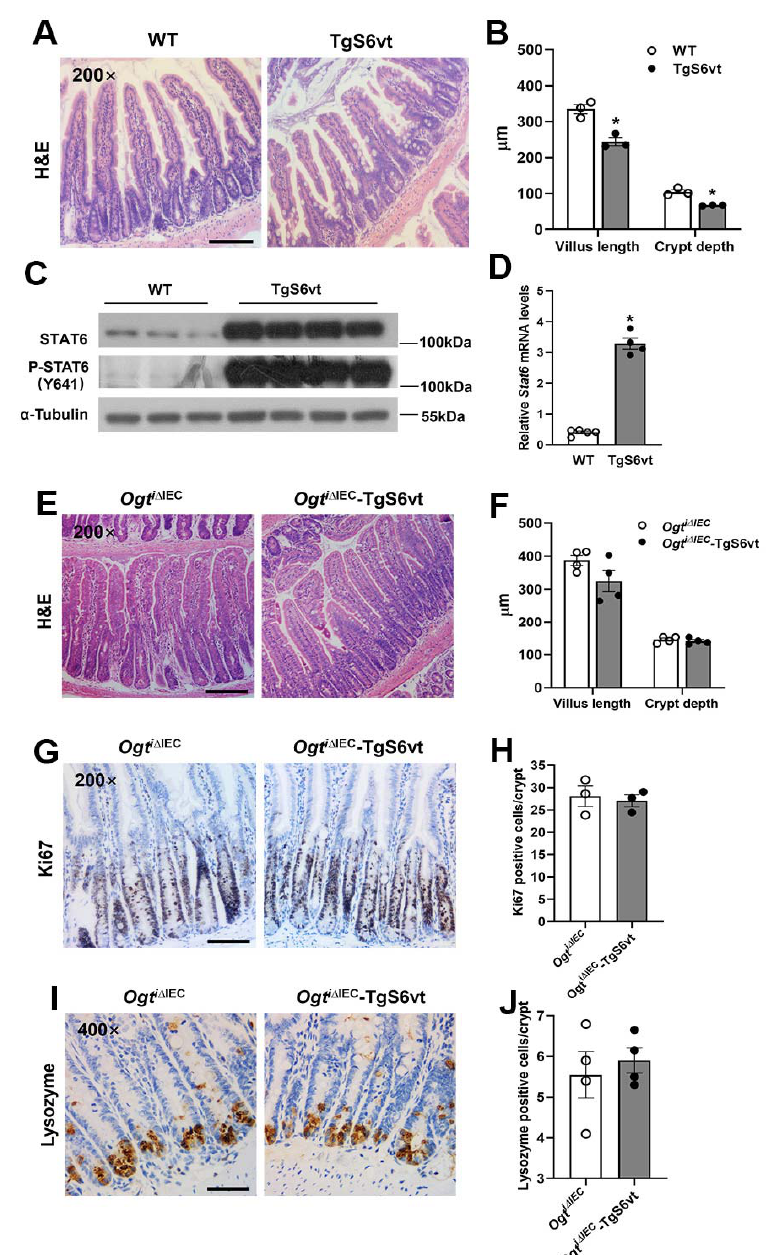
Figure 4. OGT regulates intestinal crypt cell proliferation and Paneth cell differentiation in a STAT6- independent manner. ( A – D ) The 7–8-week-old male WT and TgS6vt mice were subjected to the following assays. ( A ) Representative H&E images of the jejunum. ( B ) Analyses of jejunal villus length and crypt depth ( n = 3/group, 30 villi or crypts counted for each mouse). ( C , D ) Western blot ( C ) and qPCR ( D ) analyses of STAT6vt expression in the jejunal IECs ( n = 4/group). ( E – J ) The 9–11-week-old male Ogt i ∆ IEC and Ogt i ∆ IEC -TgS6vt mice were subjected to the following analyses. ( E ) Representative H&E images of the jejunum. ( F ) Analyses of jejunal villus length and crypt depth ( n = 4/group, 20 villi or crypts counted for each mouse). ( G ) IHC staining for Ki67 in the jejunum. ( H ) Quantification of Ki67 positive cells shown in ( G ) ( n = 3/group, 30 crypts counted for each mouse). ( I ) Jejunal Paneth cells were examined by Lysozyme IHC staining. ( J ) Quantification of Paneth (Lysozyme positive) cells shown in ( I ) ( n = 4/group, 20 crypts counted for each mouse). Data are presented as mean ± SEM. * p < 0.05. Scale bars, 100 μ m in ( A , E , G ); 50 μ m in ( I ).